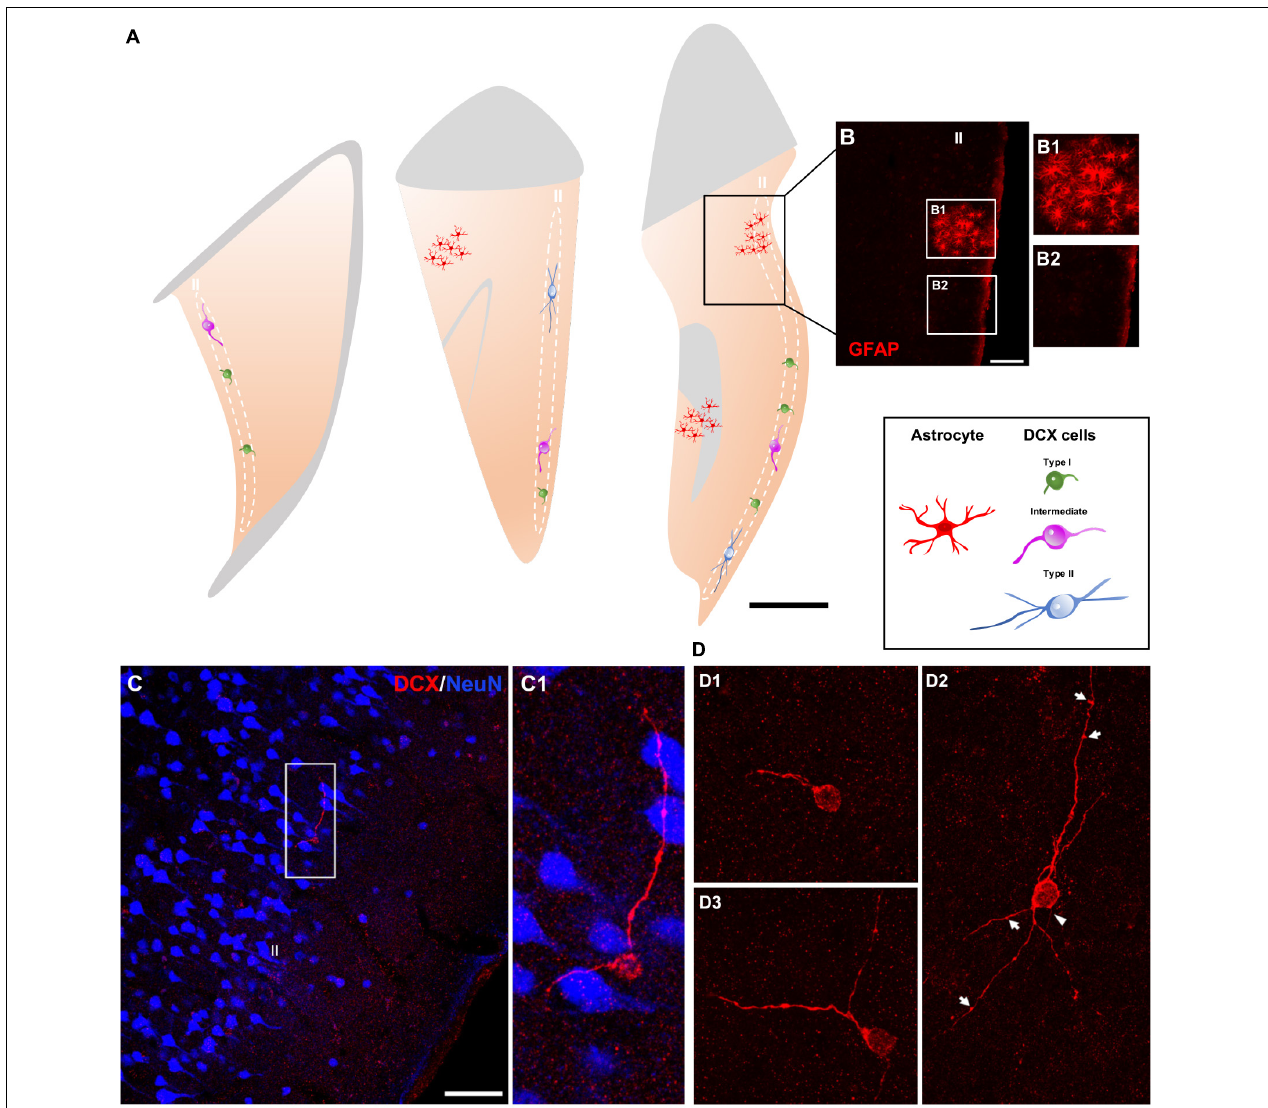
FIGURE 1 | Distribution and morphology of DCX expressing cells in the human cerebral cortex layer II. (A) Schemes of 3 representative 50 µ m coronal sections of temporal cortex, showing areas with reactive astrogliosis (red) and DCX immunoreactive cells in the layer II displaying different morphologies (type I, green; intermediate, magenta; type II, blue). (B) Confocal image of the squared area in (A) , showing GFAP immunofluorescence. (B1,B2) Are higher magnifications of the squared areas in (B) showing regions with (B1) or without (B2) reactive astrocytes. (C) Double-immunofluorescence for DCX (red) and NeuN (blue) in the temporal cortex. Note a DCX + cell with its soma located in the layer II and lacking a NeuN immunoreactive nucleus. NeuN immunohistochemistry was used to define the six-layered cerebral cortex. (C1) Is a higher magnification of the squared area in (C) . (D) 2D projections of confocal stacks (5 confocal planes separated by 1 µ m) showing DCX expressing cells: type I (D1) , type II (D2) , and intermediate (D3) . A thin process resembling an axon (arrowhead) and sparse protrusions similar to stubby dendritic spines (arrows) can be observed in the type II cell shown in figure (D2) . In (A) white and gray matters are indicated with gray and light-orange colors, respectively. Scale bars: 30 mm for (A) ; 70 µ m for (B) ; 35 µ M for (B1,2) ; 70 µ m for (C) ; 20 µ m for (C1) ; 30 µ m for (D1–3) . All schemes and confocal images in this figure were from neurosurgical